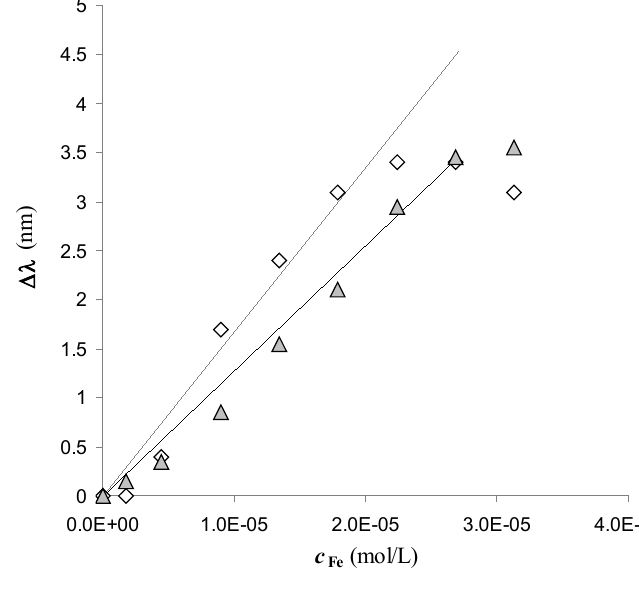
Figure 6. Standardization curves of Fe(III) on DFO-SAM-POF sensor. : Δ λ obtained from the transmission spectrum in 0.5% M HNO : Δ λ obtained from the transmission spectrum in 0.01 M Na after each